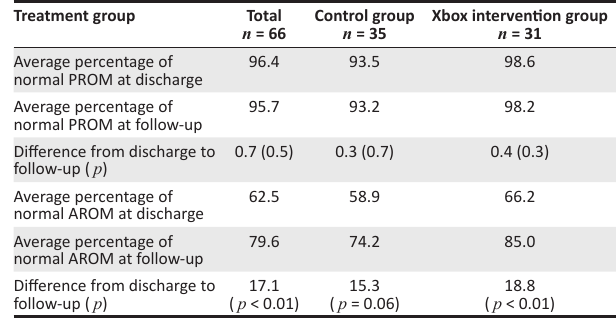
TABLE 3: The percentage of passive range of motion and active range of motion for the total sample and the two groups at discharge and at follow-up ( n = 66). Treatment